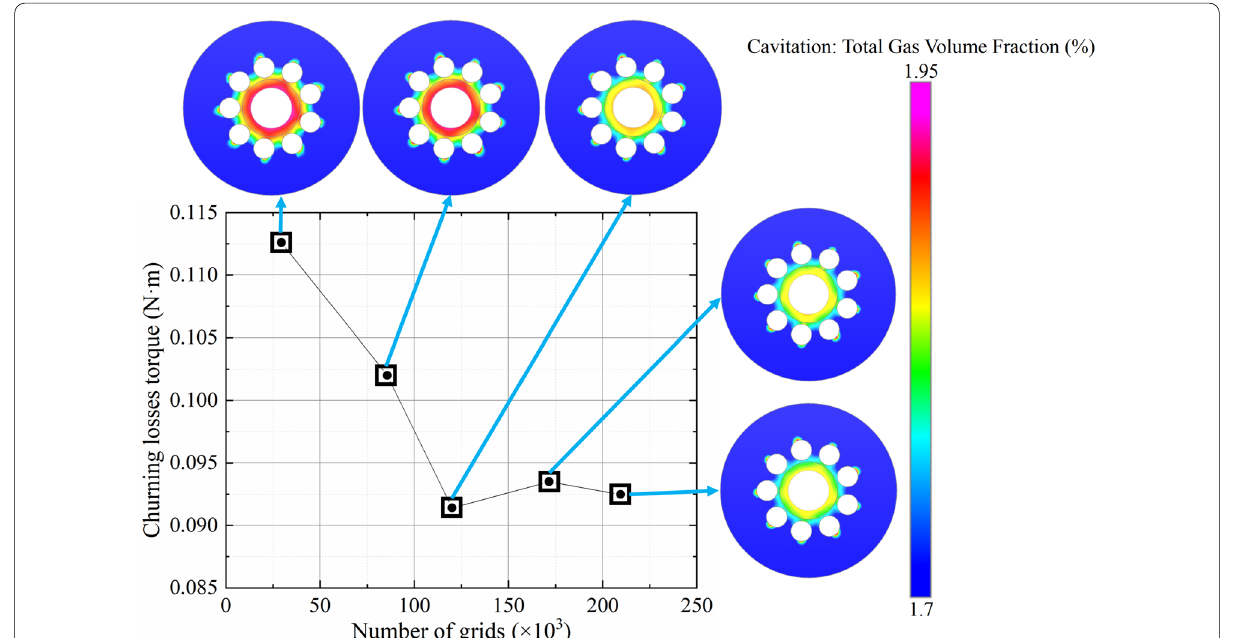
Figure 4 Torque value and cavitation degree under different grid